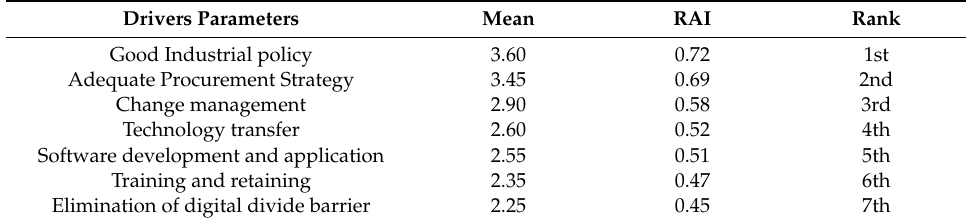
Table 13. Industrial application drivers in achieving Construction